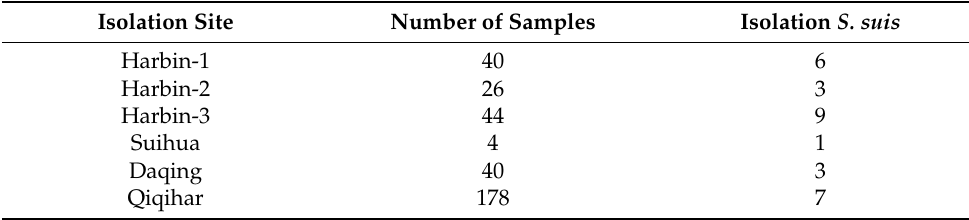
Table 2. Number of isolates and sites of regions used in the